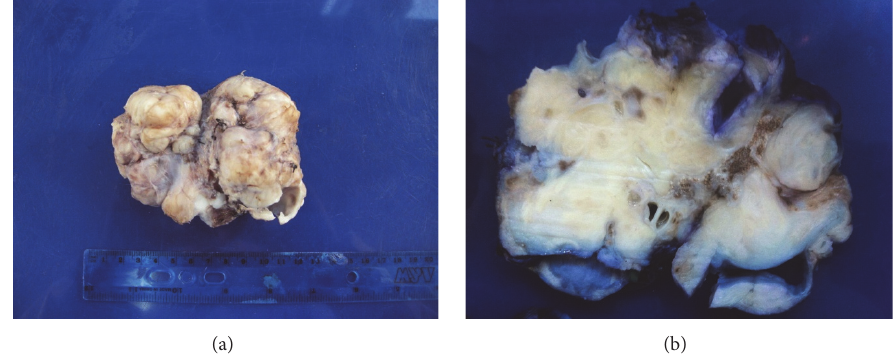
Figure 2: Gross appearance showing irregular tan-white mass (a) and (b) cut section showing a heterogeneous surface with solid and cystic areas along with bony